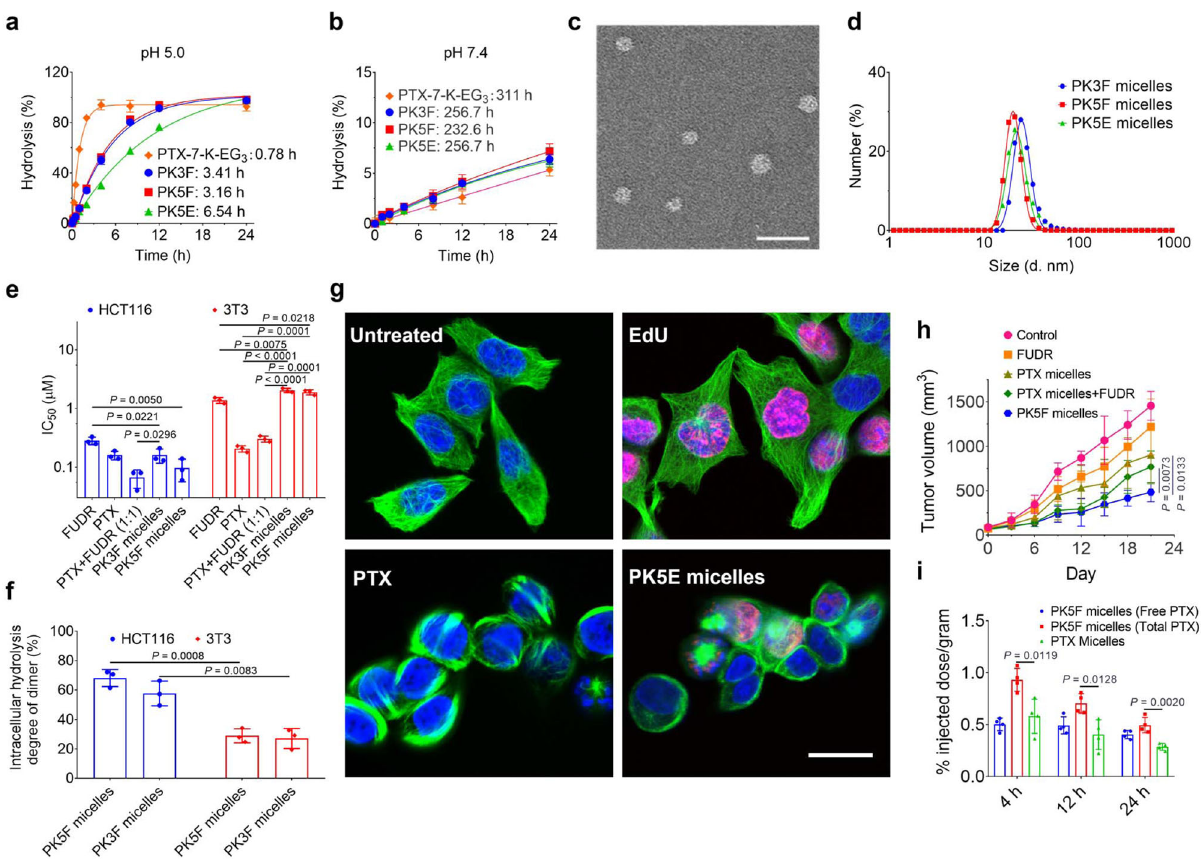
Fig. 5 In vitro and in vivo characterizations of PTX prodrugs. Hydrolysis of PTX prodrugs at ( a ) pH 5.0 and ( b ) pH 7.4. Data of ( a ) and ( b ) are means ± SD ( n = 4 independent samples). c Representative transmission electron microscope image of PK5F-loaded micelles; scale bar = 50 nm. Experiments were performed three times independently, and one representative image is shown. d Sizes of heterodimer-loaded micelles, determined